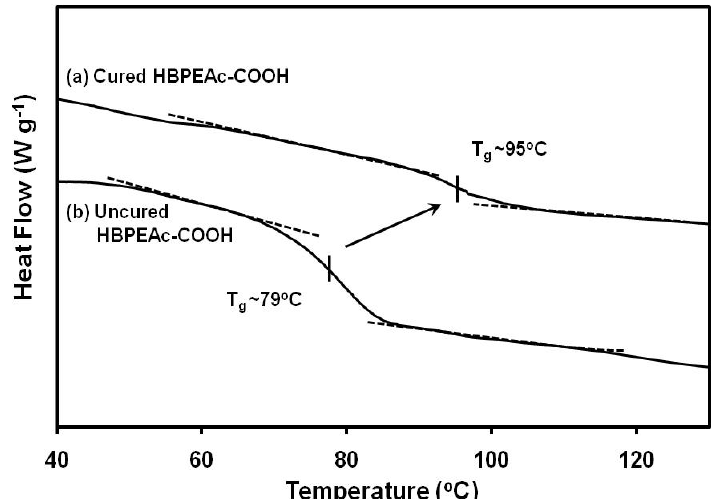
Figure 1. Differential scanning calorimetry (DSC) thermograms of pure HBPEAc-COOH ( a ) before and ( b ) after photocuring exhibiting an increase in T supramolecules upon